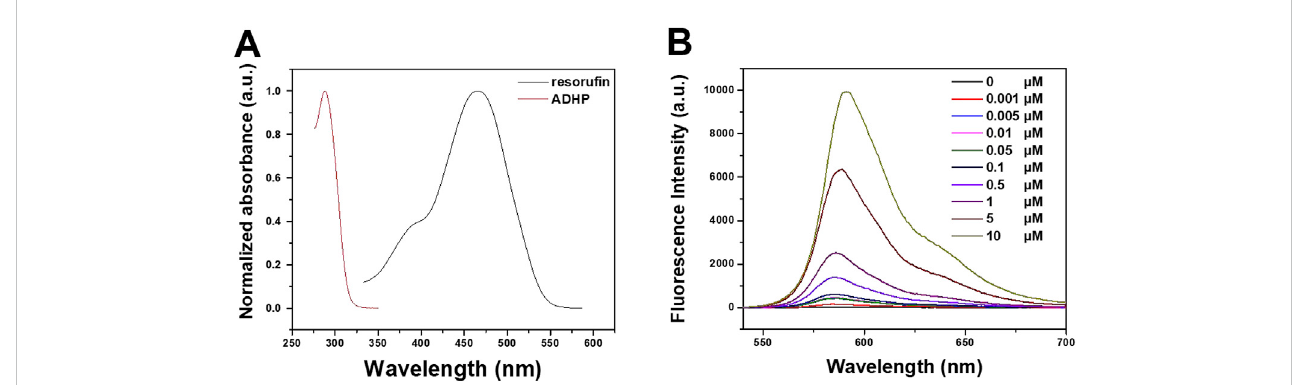
FIGURE 2 (A) Absorption spectra of ADHP and resoru fi n in DMOS. (B) Fluorescence intensity variation of ADPH in response to different concentrations of H 2 O 2 .